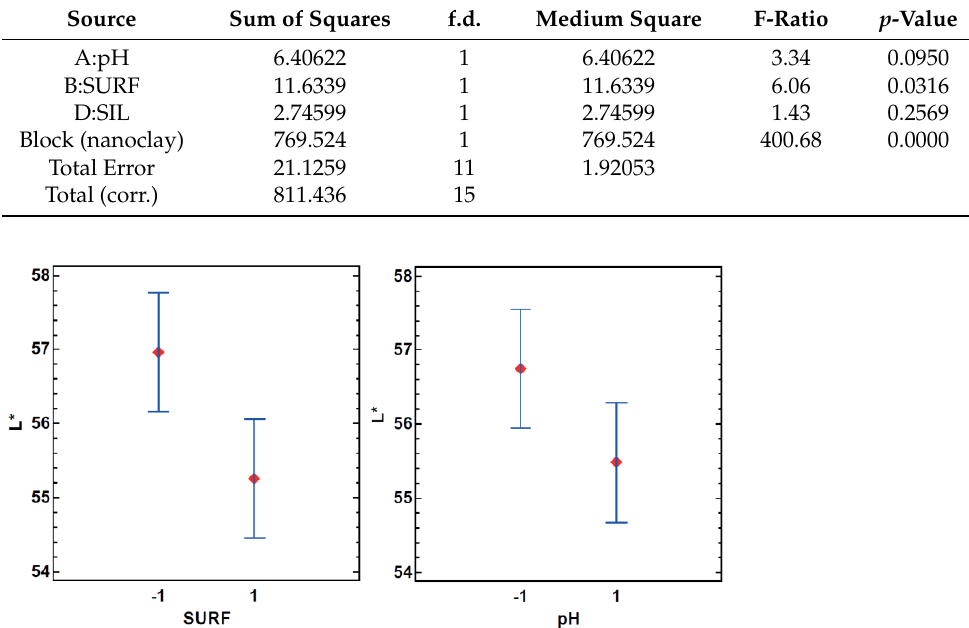
Figure 11. The LSD median plots for the SURF and CLAY factors with the L*